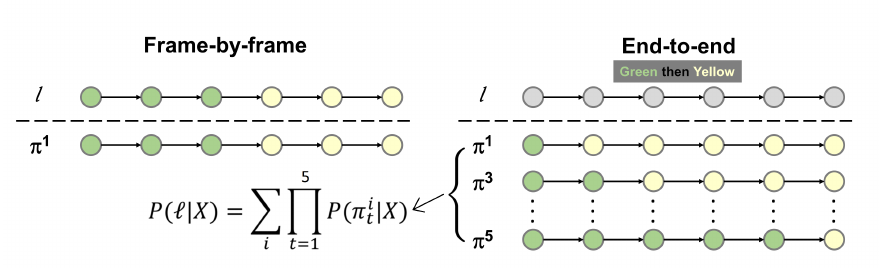
Figure 4. Blank nodes indicate unlabeled frames. CTC addresses the problem of unknown labels by aggregating associate paths (Equation